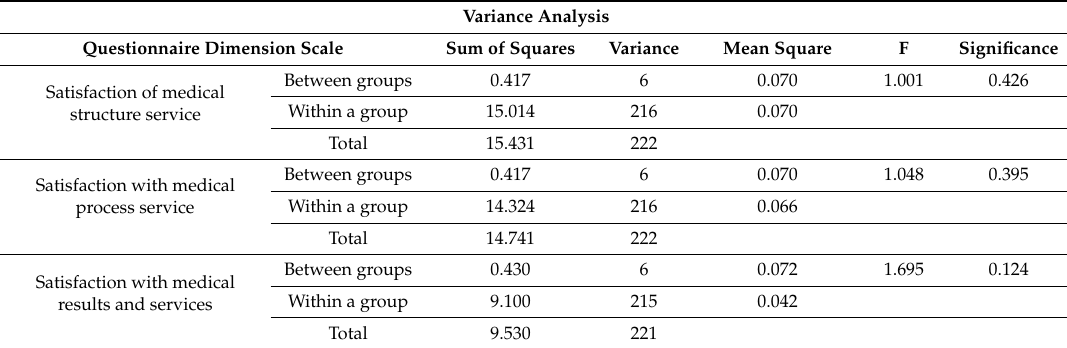
Table 24. Analysis of occupational category and scale dimension variables.